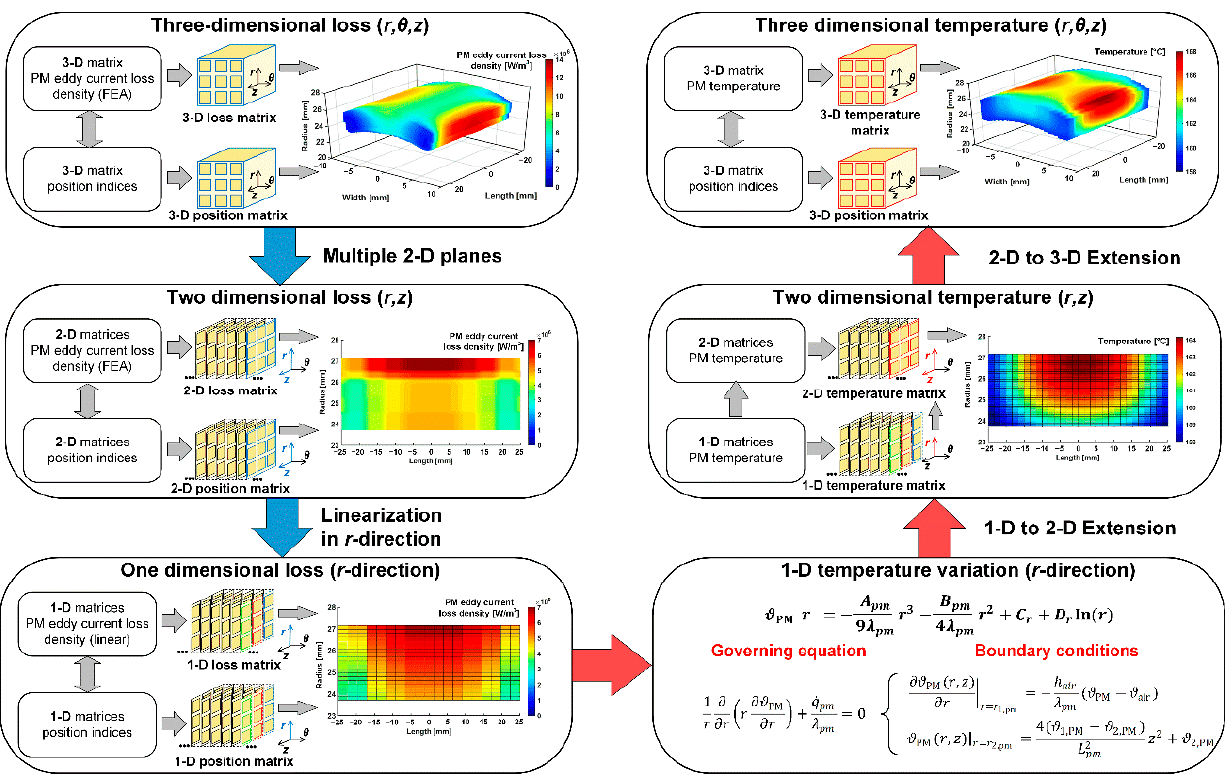
Figure 28. Mathematical processing of PM eddy current loss and simplified analytical thermal modelling for a 12-slot/10-pole SPMSM [61].